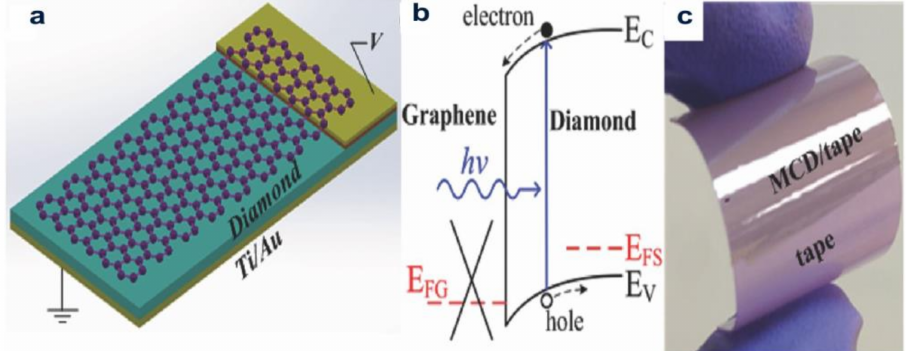
Figure 13. ( a ) Concept map of the solar-blind UV detector on the basis of the microcrystalline diamond-graphene heterojunction; ( b ) frequency band sketch map of the system under UV illumina- tion; ( c ) Optical photograph of the tape/flexible MCD/metal bended between two human fingers [34].